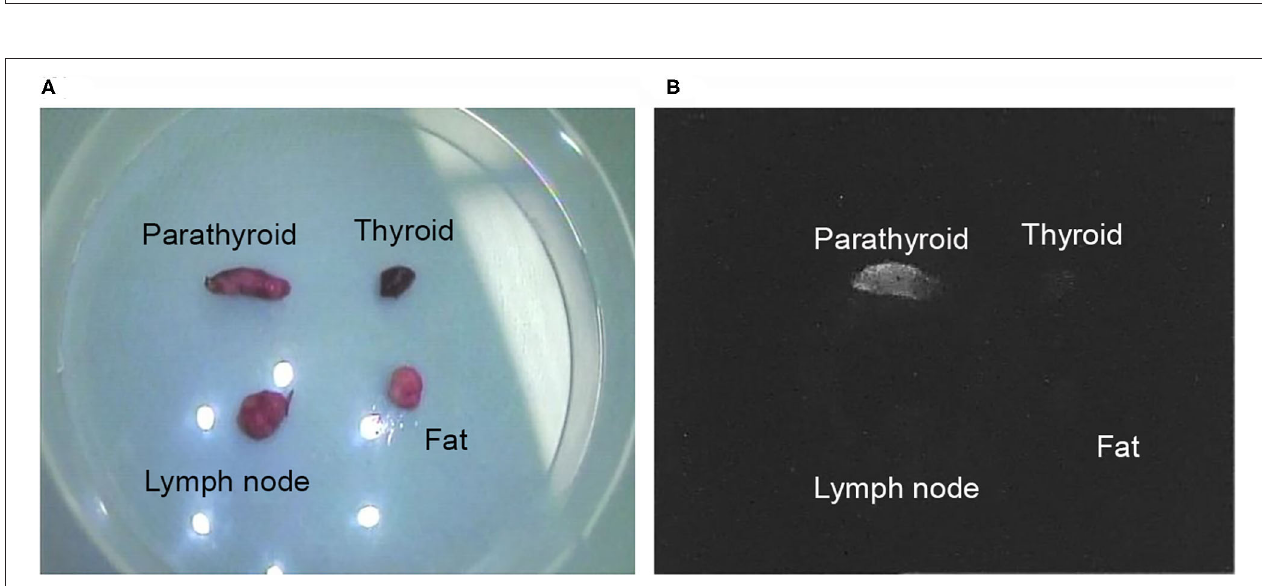
FIGURE 4 | Video image sample clip of the collected material. One sample set image clip of the parathyroid gland, thyroid, lymph node, and fat tissue are shown in one view to compare the relative illumination intensity ratio: (A) the optic visual light view under white light; (B) and fluorescence view.